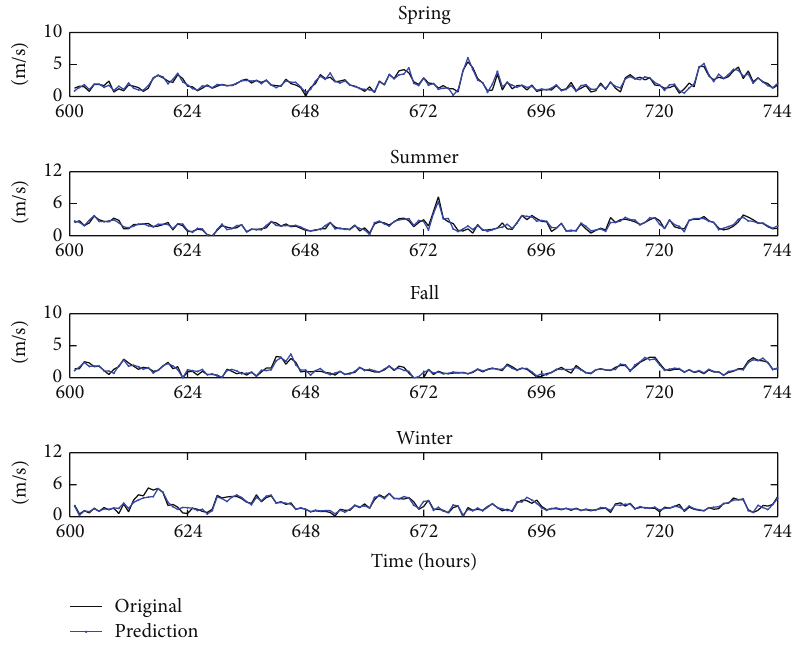
Figure 7: The prediction results of the original wind speed series by the proposed